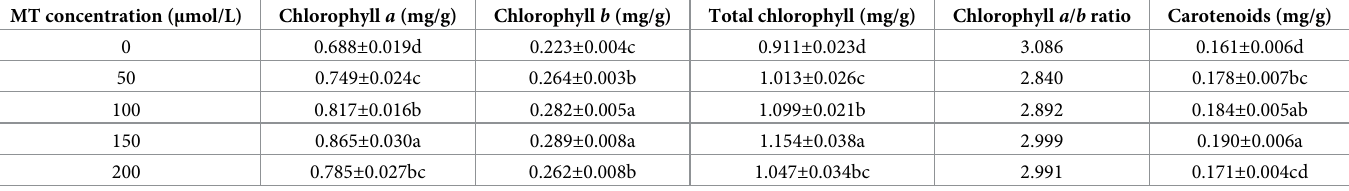
Values are means ( ± SE) of three replicate pots. Different lowercase letters within a column indicate significant differences based on one-way analysis of variance in SPSS 22.0 followed by the least significant differences ( p �